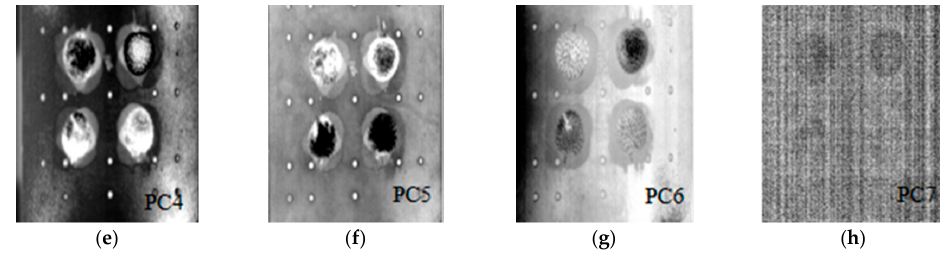
Figure 7. Litchi fruit images by principal component analysis. ( a ) Original image 1. Fresh, 2. Newly